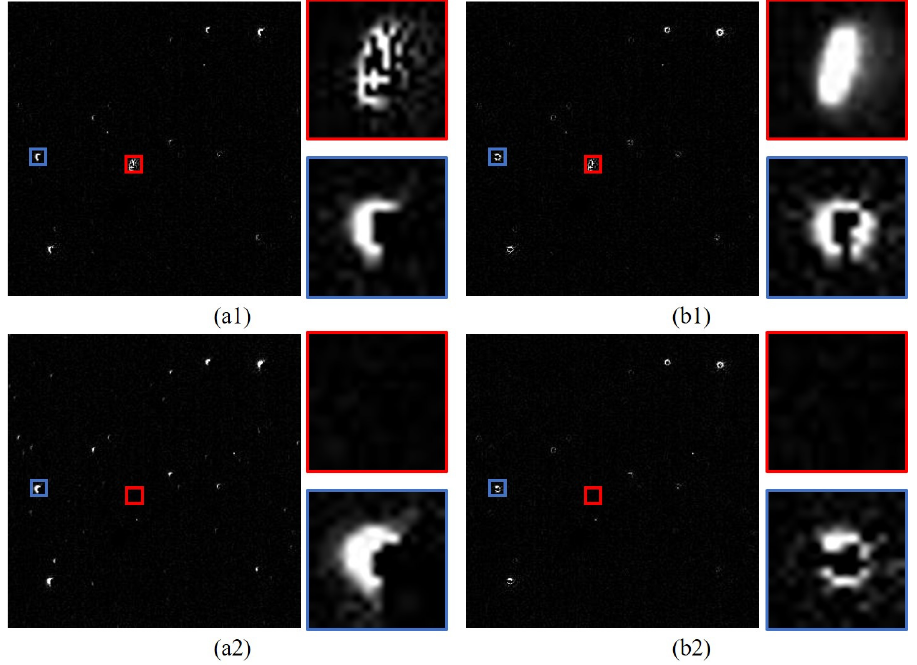
Figure 10. Region 3 in the difference images using ( a ) affine transformation and ( b ) homography transformation. ( a1 , b1 ) The difference image of the second frame and the reference image. ( a2 , b2 ) The difference image of the tenth image and the reference